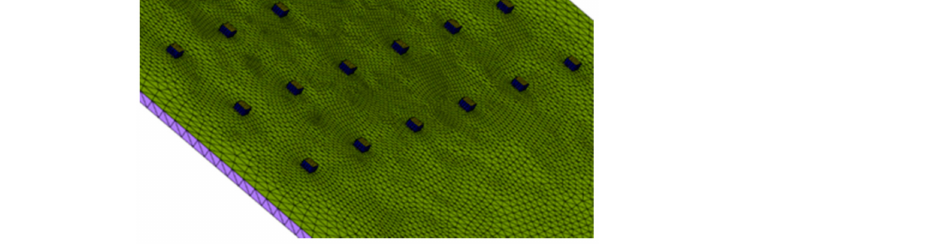
Figure 6. Discretized PCB and LED diode. Source: our own elaboration from the software Hyper- Mesh.